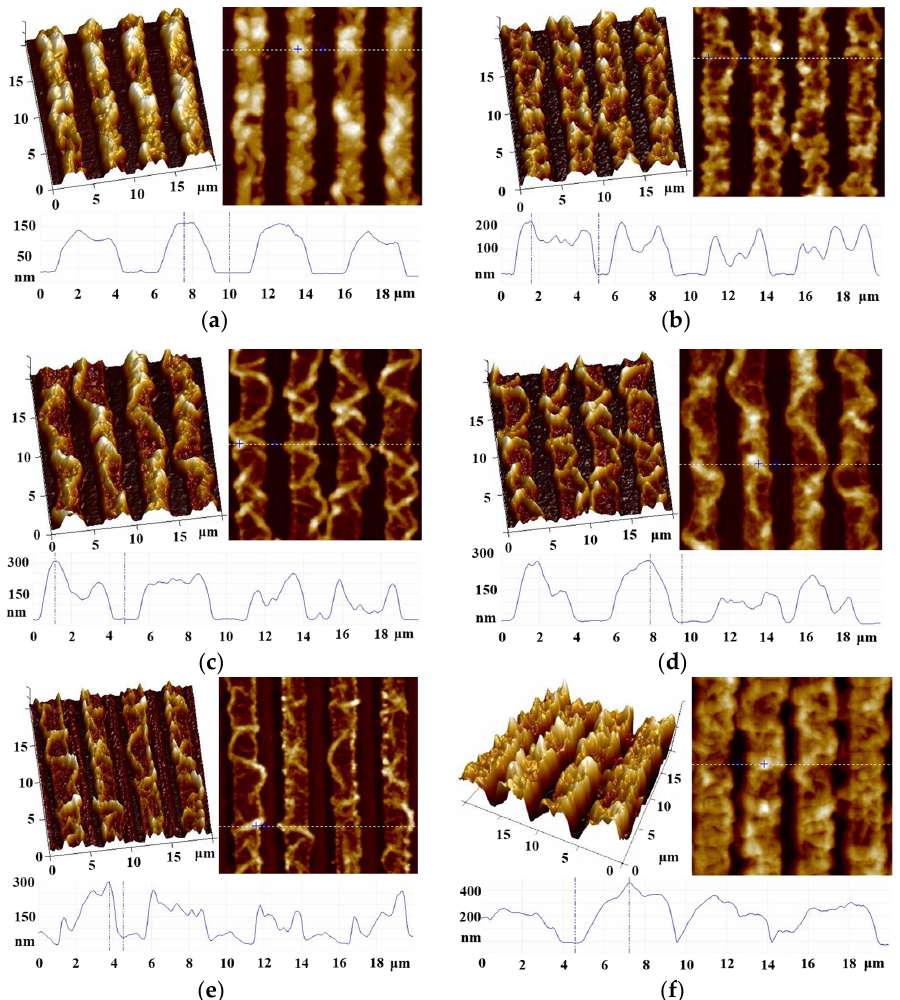
Figure 3. 2D and 3D AFM images and cross-section profiles of ( a ) DG-g-PMAA1, ( b ) DG-g-PMAA2, ( c ) DG-g-PMAA4, ( d ) DG-g-PMAA6, ( e ) DG-g-PMAA8, and ( f ) DG-g-PMAA16.